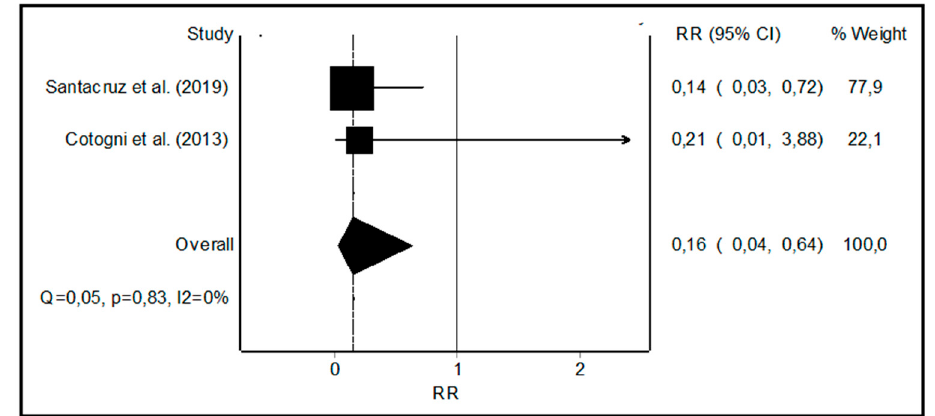
Figure 3. Forest plot showing the relative risk (RR) of catheter-related bloodstream infection (CRBSI) with peripherally inserted central catheters (PICCs) vs. ports. I 2 , a measure of heterogeneity.